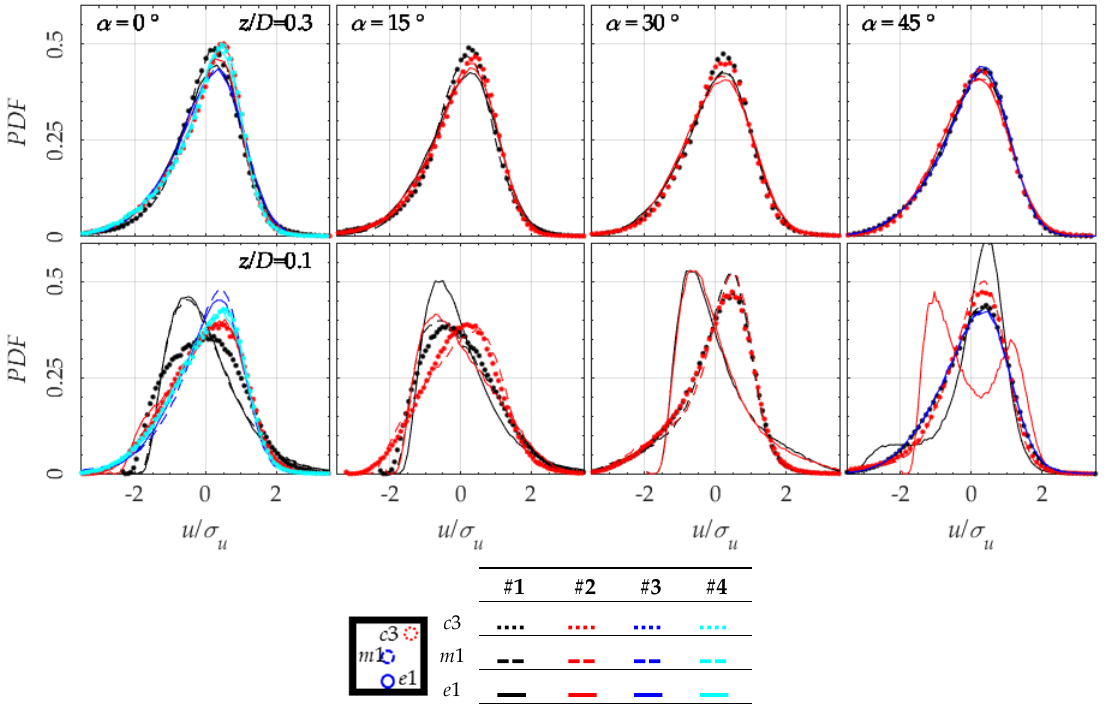
Figure 16. Probability Distribution Function for locations e 1 ( ), m 1 ( ) and c 3 ( ) at z = 3 m (bottom) and z = 12 m (top) for the 4 wind directions (columns).